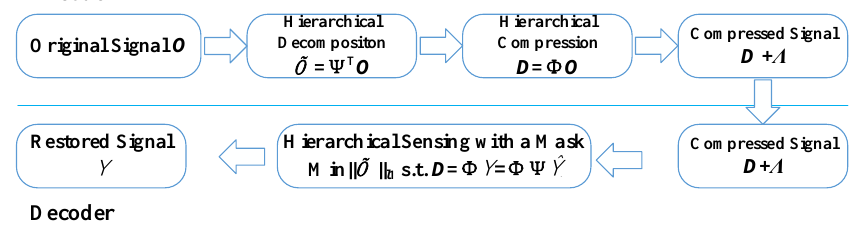
Figure 3. Architecture design of Wireless transmission method for large data.